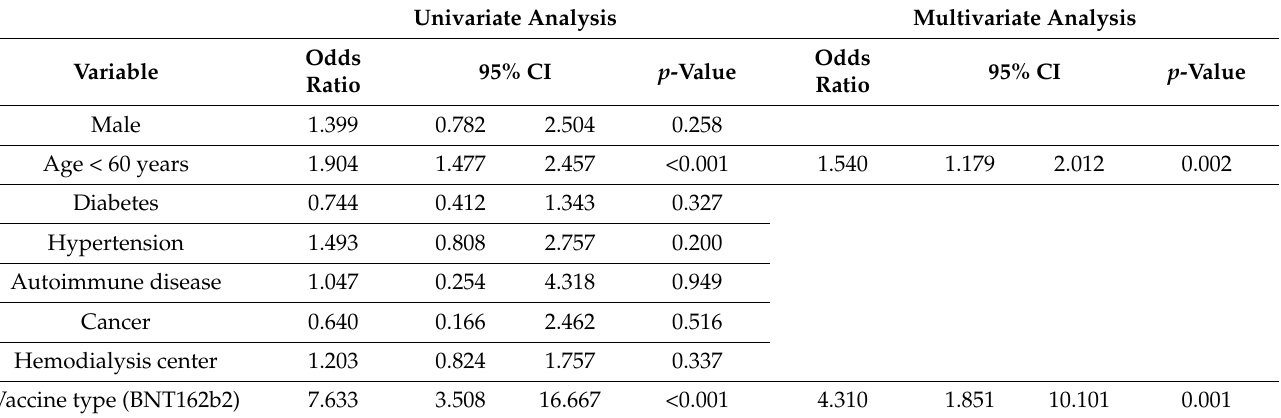
Table 3. Evaluation of predictors of vaccine responsiveness 4 months after the two-dose vaccination. Univariate and multivariate logistic regression of demographic, clinical, and laboratory parameters of patients. Variables included in the multivariate model were those with a p -value below 0.1 in the univariate analysis. Variables considered as predictors of vaccine effectiveness were those with a p -value below 0.05 in the multivariate model. Odds ratios and their 95% confidence intervals (95% CI) and p -values are detailed. Univariate Analysis Multivariate